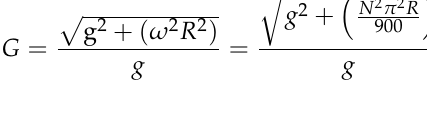
Figure 2. The weights of filtrate and residual in the trials 1–9.